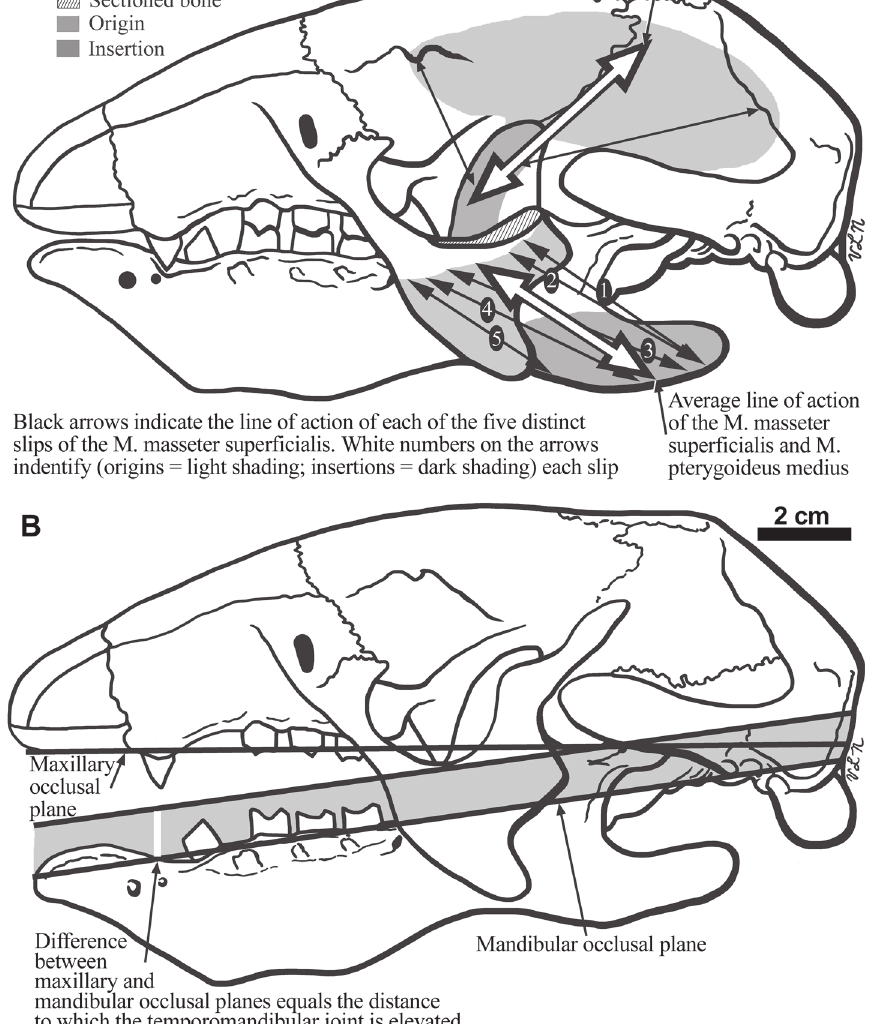
Figure 8. The cranium of Hapalops is shown in lateral view ( B ), illustrating the differential height of the craniomandibular joint for the skull and mandible. In A , the lines of action of the five individual parts, and a composite line of action of the M. masseter superficialis, and the anterior and posterior as well as a composite line of action for the M. temporalis are